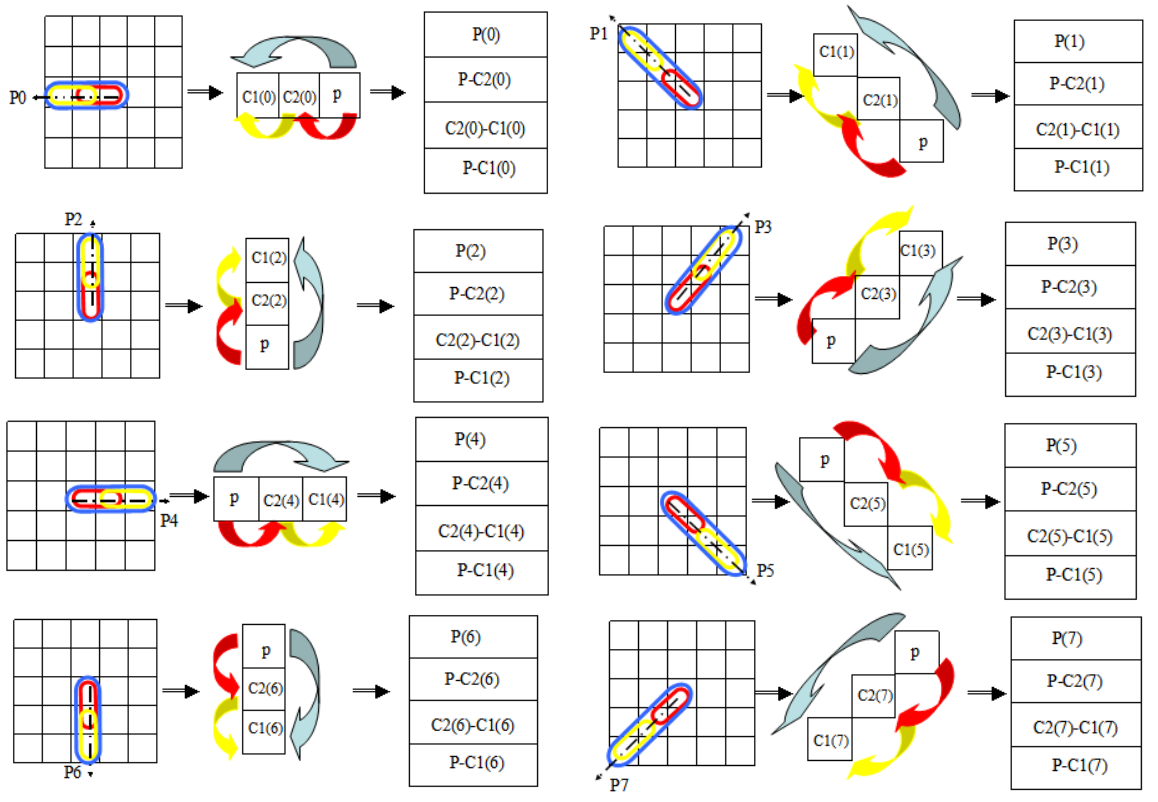
Figure 4. The principle of the layer directed derivative feature